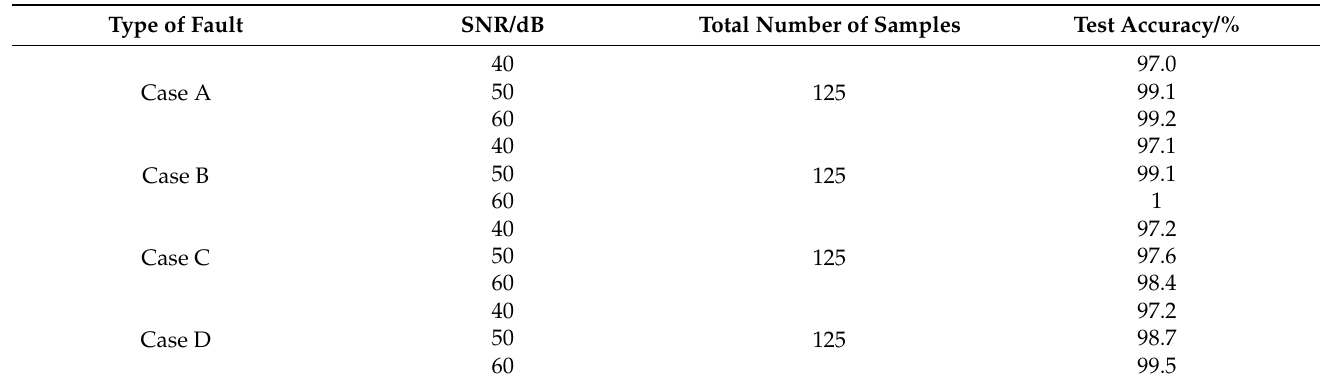
Table 3. Performance analysis of the algorithm under noise interference conditions.